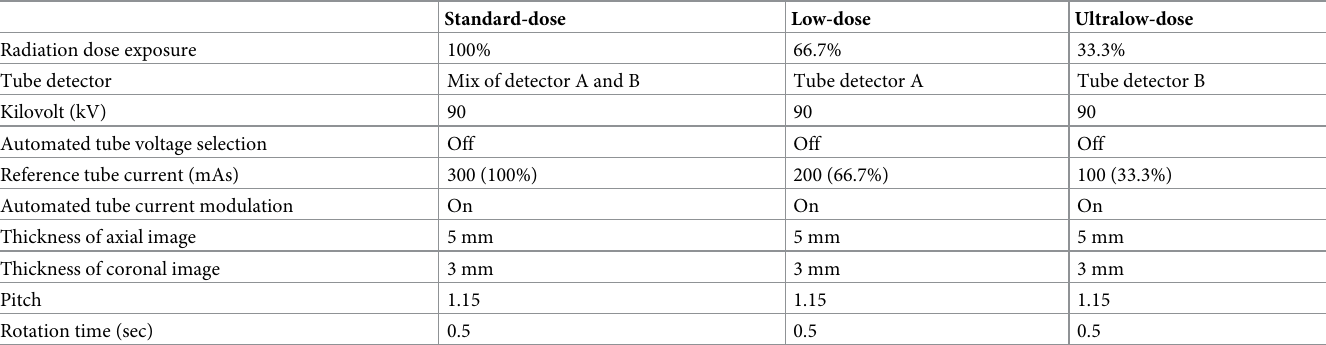
Table 1. Reconstruction parameters.